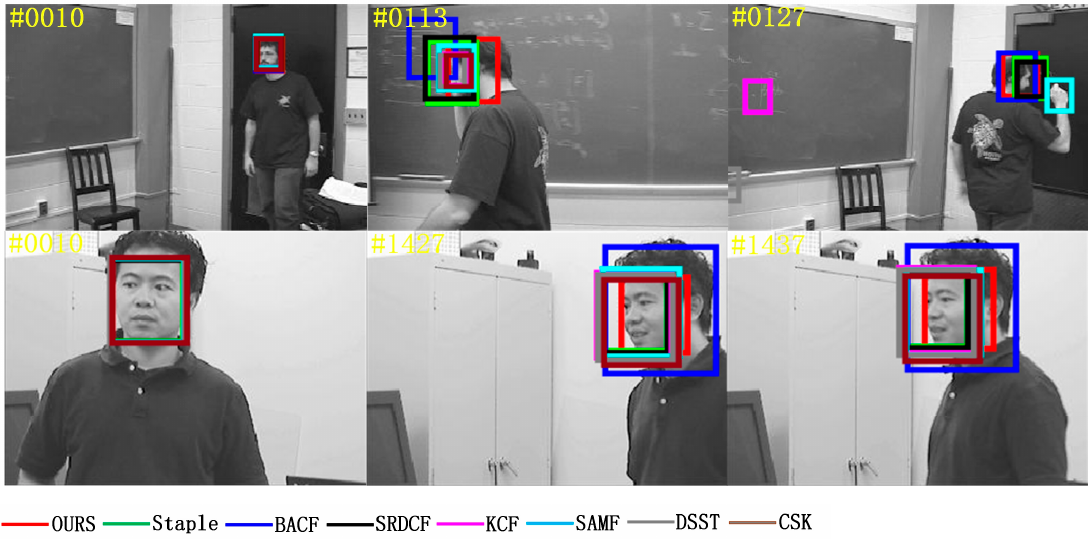
Figure 10. Visual comparison with eight trackers in the “Freeman1_1” and “Mhyang_1” video sequences in an occlusion challenge scenario.